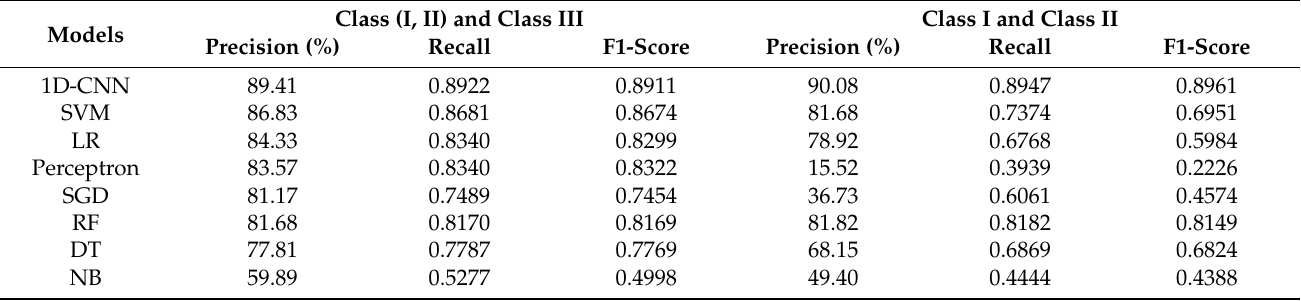
Table 1. Precision, recall, and F1-score of the classification for different models.